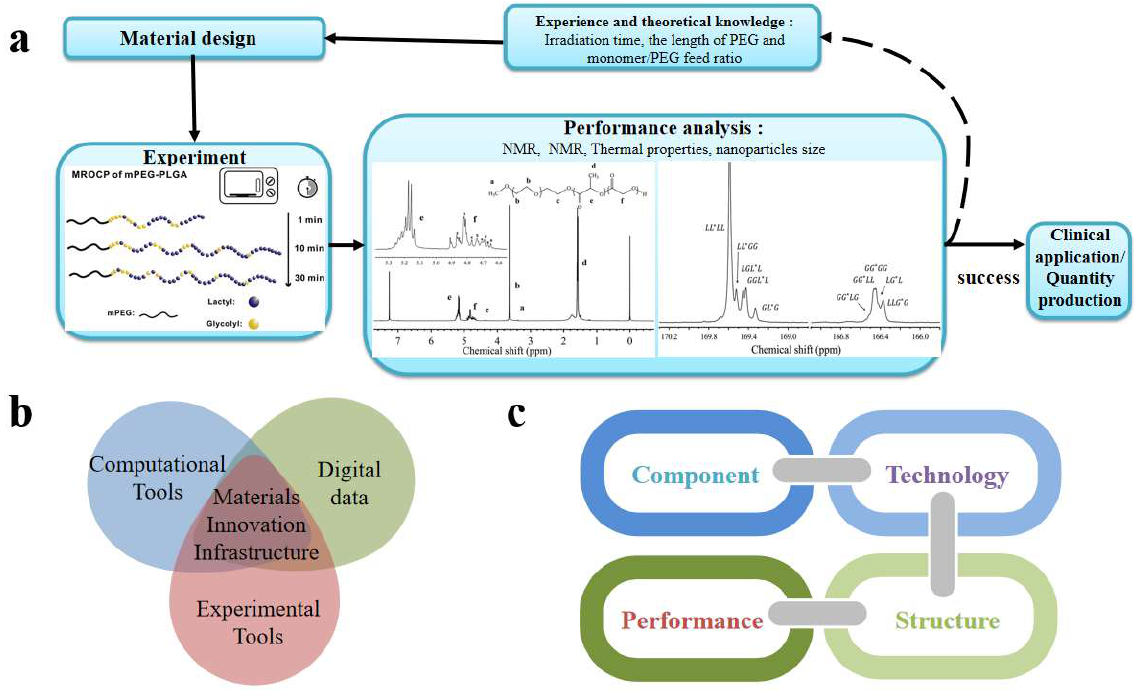
Figure 1. The traditional trial and error research process with Jing [9] as an example ( a ). Three ele- ments of MGI ( b ) and the connection between material composition, synthesis technology, structure, and material performance ( c ).